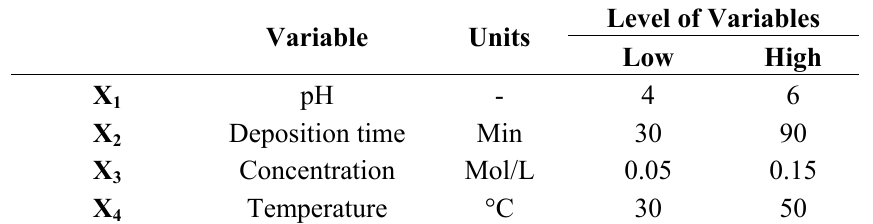
Table 2. Independent variables and their levels employed in the factorial